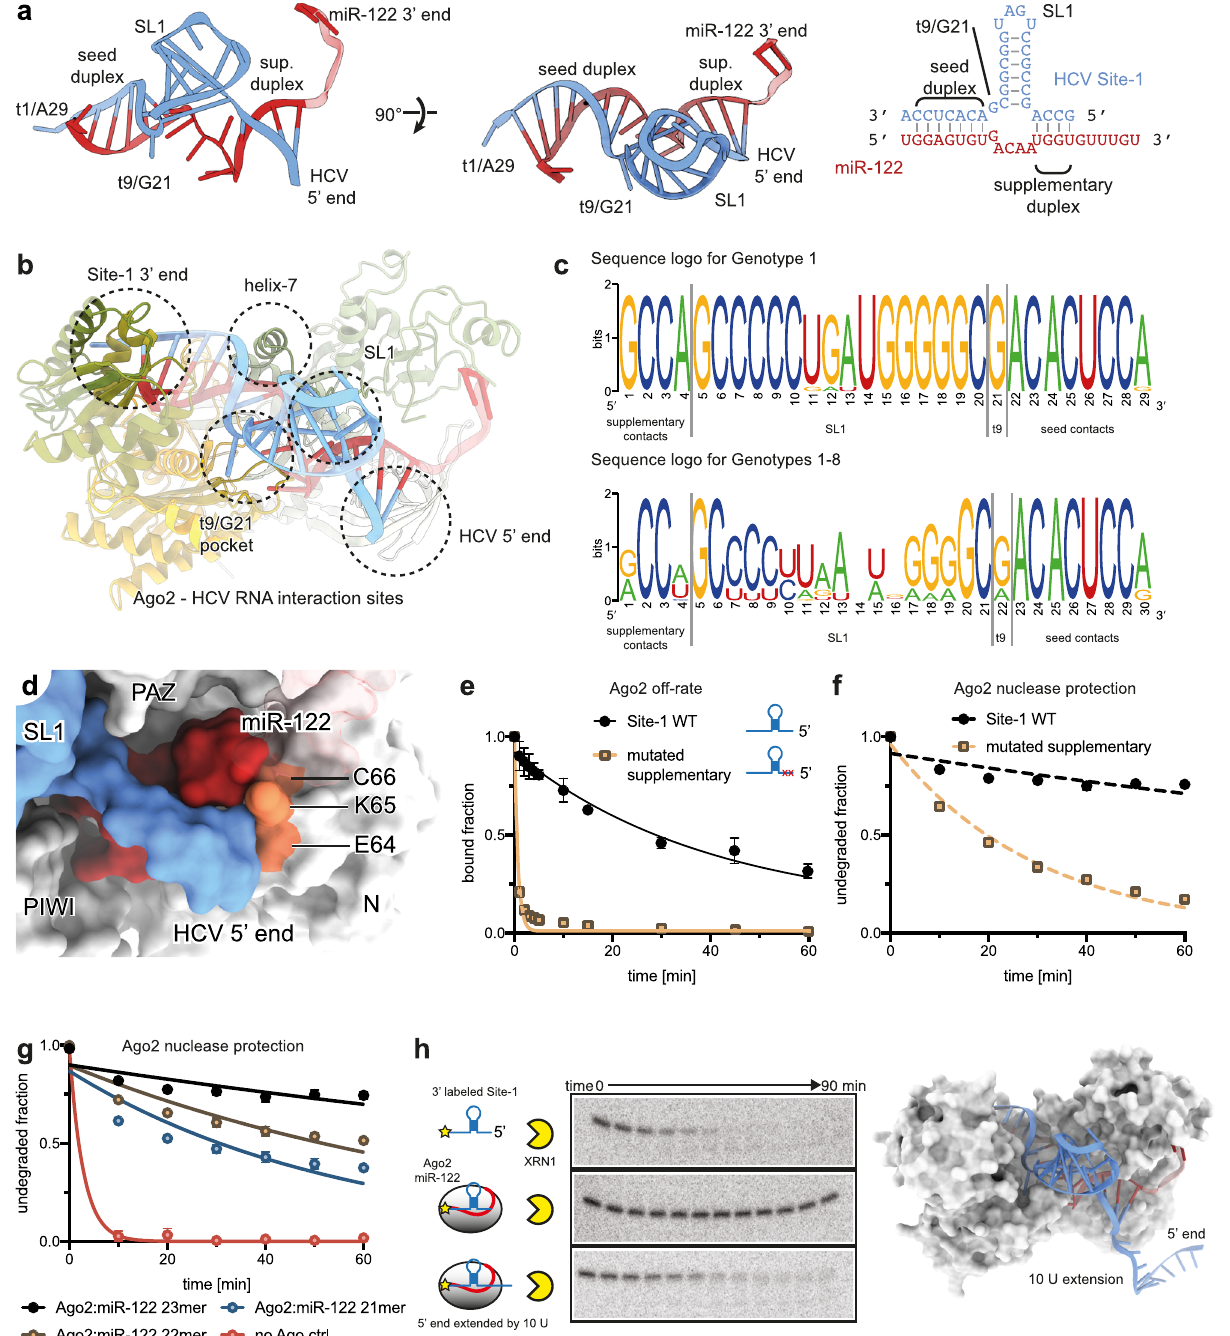
Fig. 2 Ago2 shields the HCV 5 ’ end from enzymatic attack. a 3D structures (left) and schematic representation (right) of the miR-122:Site-1 three-way junction, composed of the seed duplex, SL1, and the supplementary duplex. b Cartoon representation of Ago2 with major HCV RNA contacts highlighted (determined by PDB PISA 50 ). c Multiple sequence alignment of HCV genotype 1 subtype sequences (top) and genotype 1-8 subtype sequences (bottom). The total height of the letters at each position corresponds to the conservation at that position, while the height of the letters within the stack corresponds to their relative frequency. Supplementary contacts, SL1, t9, and seed contacts are indicated. d Surface representation showing closeup of the HCV RNA (blue) 5 ’ end bound to miR-122 (red) and positioned against the N-terminal domain residues E64, K65, and C66 (orange). e Ago2:miR-122 off-rate experiment using Site-1 WT and Site-1 with supplementary-pairing region mutated (GCCA > GAAA). Data shown as means of 3 independent replicates with error bars representing SEM. f XRN1 mediated degradation of Site-1 WT and with mutated supplementary-pairing region RNAs in the presence of Ago2:miR-122. Data shown as means of 3 independent replicates with error bars representing SEM. g XRN1 mediated degradation of WT Site-1 in presence of Ago2 loaded with indicated miR-122 3 ’ isomiRs, or no Ago2. Data shown as means of 3 independent replicates with error bars representing SEM. h Polyacrylamide gels showing XRN1 mediated degradation of Site-1 RNA alone (top), Site-1 with Ago2:miR-122 (middle), and Site-1 containing a 5 ’ U 10 extension with Ago2:miR-122. Images are representative gels of triplicate experiments. Ago2:miR-122:Site-1 structure with U 10 extension modelled (right) to illustrate potential 5 ’ end exposure.